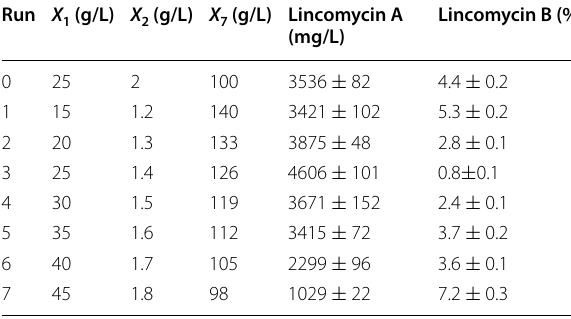
The values were obtained from three independent